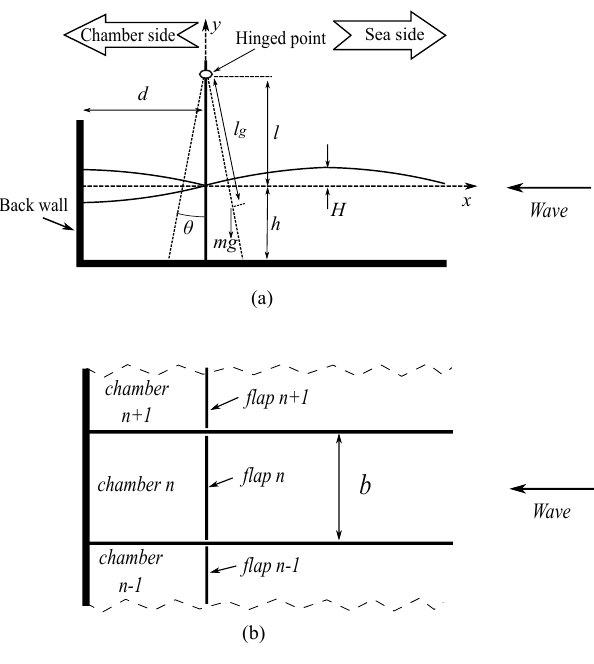
Figure 2. Schematic representation of the Pendulor device in a breakwater (( a ) side elevation; ( b ) plan